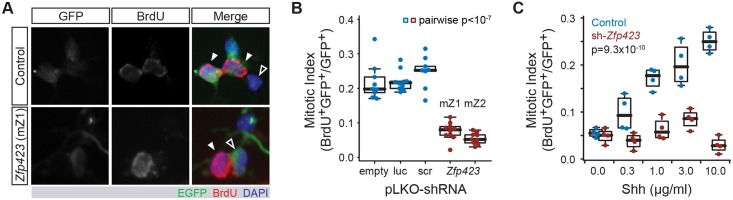
Zfp423 shRNA blocks proliferation and Shh response of purified granule cell precursors.(A) Examples of GCPs transfected with scrambled control or Zfp423-targeted shRNA constructs, in the presence of 3 μg/ml Shh. Transfected cells express EGFP from the shRNA vector (green). Proliferating cells are labeled by BrdU incorporation for 6 hr, at 48 hr after transfection (red). Control panels show dividing transfected cells (left-slanting closed arrowheads) and a non-dividing, non-transfected, cell (open arrowhead). Zfp423 (shRNA mZ1) panels show a dividing non-transfected cell (right-slanting closed arrowhead) and a non-diving transfected cell (open arrowhead). At least two transfections for each of three independent DNA preparations were assayed for each construct. Channel levels were adjusted for merged images. (B) The proportion of EGFP+ cells labeled by BrdU is plotted for each replicate culture in the presence of 3 μg/ml Shh. shRNA sequence was a highly significant factor (p < 2.2 x 10−16, ANOVA), with each Zfp423 shRNA construct different from every control shRNA (p < 10−7 for each pair-wise comparison, Tukey Honest Significant Difference (HSD) test after ANOVA). Controls were not significantly different from each other (p > 0.4), nor were the two Zfp423 hairpin sequences (p > 0.4). Empty, pLKO vector with no hairpin sequence; luc, luciferase; scr, scrambled sequence control; mZ1 and mZ2 are non-overlapping shRNA sequences designed against Zfp423 from the RNAi consortium collection. (C) GCP cultures were transfected with control (scr) or Zfp423-targeted (mZ1) shRNA constructs and treated with 0–10 μg/ml Shh. Transfected cells were recognized by EGFP fluorescence, replicating cells by BrdU incorporation. Plotted points indicate mitotic index of transfected cells for each of four replicate experiments at each of the indicated Shh concentrations. A minimum of three independent DNA preparations was used for transfection in each condition. The effect of Zfp423-targeting shRNA, Shh concentration, and the interaction between hairpin identity and Shh concentration were each strongly supported statistically (p = 9.3 x 10−10, 2.0 x 10−4, and 6.4 x 10−6 respectively, two-factor ANOVA).